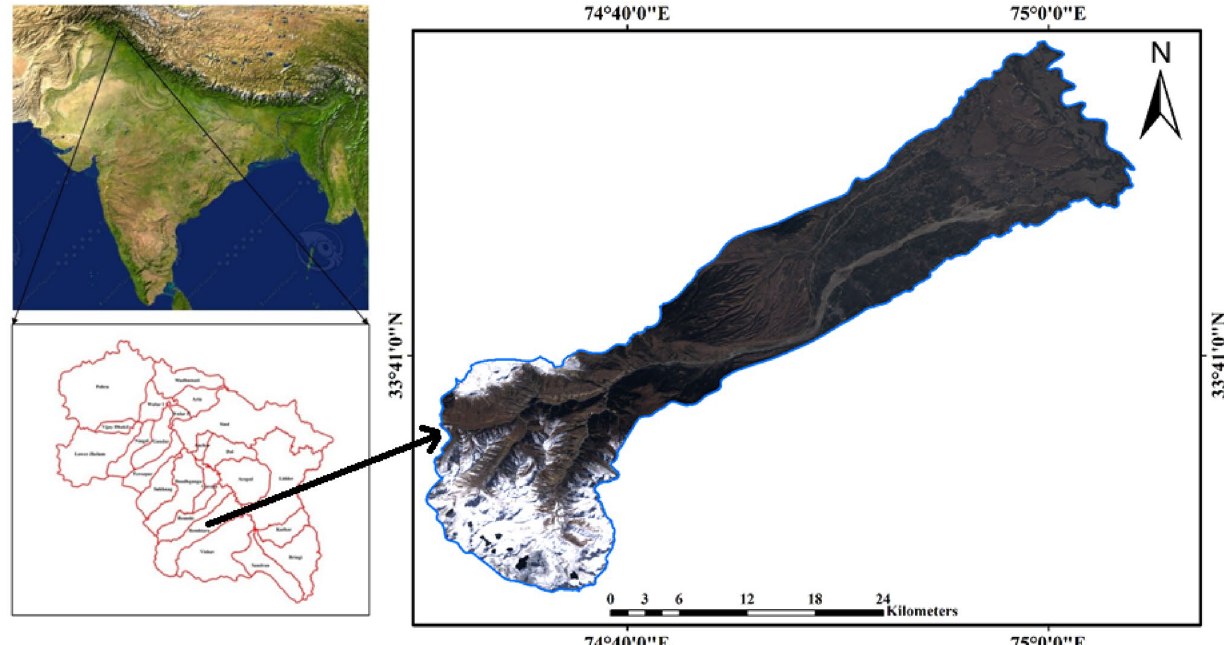
Fig. 1 Study area map showing location of Rambiara river